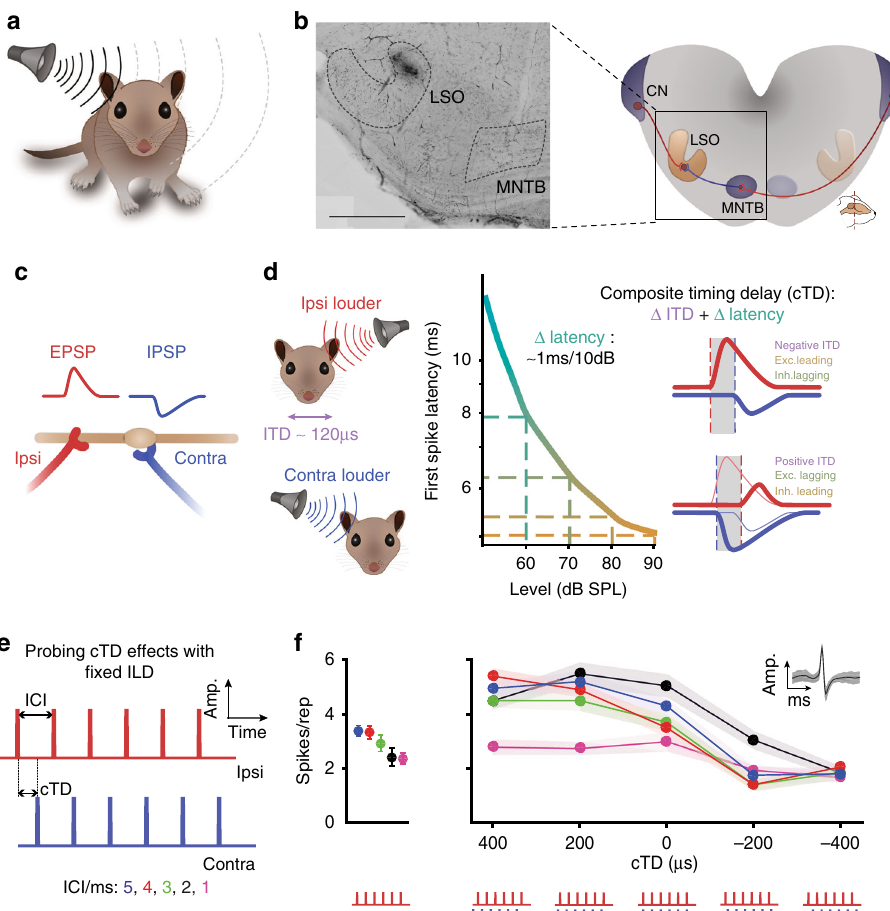
Fig. 1 ILD processing in the LSO requires high neuronal sensitivity to binaural input timing. a The acoustic head shadow produces location-speci fi c interaural level differences (ILDs) between the ears. b Right: ILDs are fi rst detected by LSO neurons by comparing ipsilateral excitatory input from the cochlear nucleus (CN) and contralateral inhibitory input from the medial nucleus of the trapezoid body (MNTB). Left: the recording site at the medial limb of the LSO for data shown in f was labeling with horseradish-peroxidase, which was deposited via the recording electrode. Scale bar: 500 µ m. c During ILD computation, LSO neurons integrate the relative strength (amplitude) and timing of inhibitory and excitatory post-synaptic potentials (IPSPs and EPSPs, respectively). d Changes in the sound source location cause signi fi cant changes in the relative timing of the inputs to the LSO: higher absolute sound intensity cause PSPs with larger amplitude, and also shorter latencies. The graph (middle panel) illustrates these level-dependent changes in fi rst spike latency of an auditory nerve fi ber (adapted from 63 ). Together with the location-speci fi c ITD (in the range of <120 µ s), these latency changes largely determine the range of input timing changes associated with changes in the location of a sound source (right panel). Thus, ILD computation also involves gauging of the relative timing of EPSPs and IPSPs. e The acoustic stimulus consisted of six clicks (50 µ s duration per click), spaced at fi ve different ICIs (1 – 5 ms in 1 ms increments). For binaural presentation, the cTD was varied between − 400 and + 400 µ s in 200 µ s steps (negative values denote ipsilateral ear leading stimuli). f Left: Mean spike rates per repetition from an example neuron (CF: 24.3 kHz) during (ipsilateral) excitatory only click train stimulation. (74 dB SPL, 20 repetitions each, ICIs color-coded as denoted in e . Right: cTD-response functions of the same neuron (ipsi: 74 dB SPL, contra: 79 dB SPL, 20 repetitions). Inset shows mean spike waveform. Filled circles and shaded areas denote mean and standard error of the mean (s.e.m.). Note that maximal response rates at + 200 and + 400 µ s cTD exceed mean rates during excitatory only